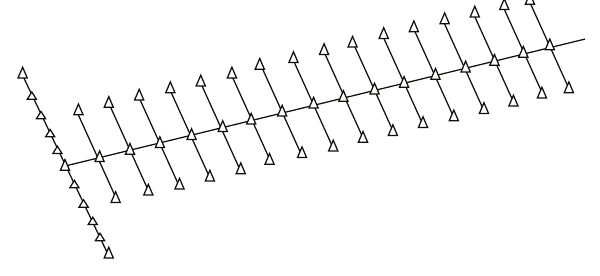
Figure 7: Structure of the FEM